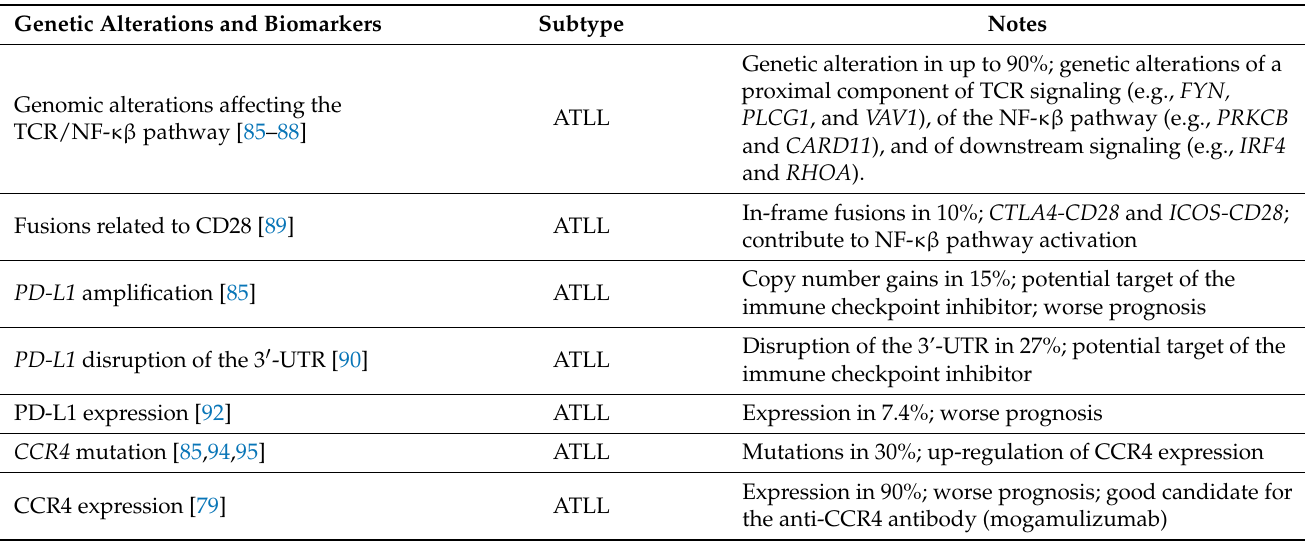
Table 4. Recurrent genetic alterations and key biomarkers of